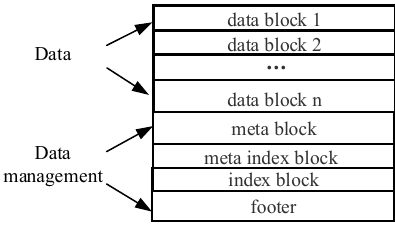
Figure 3. SSTable structure.